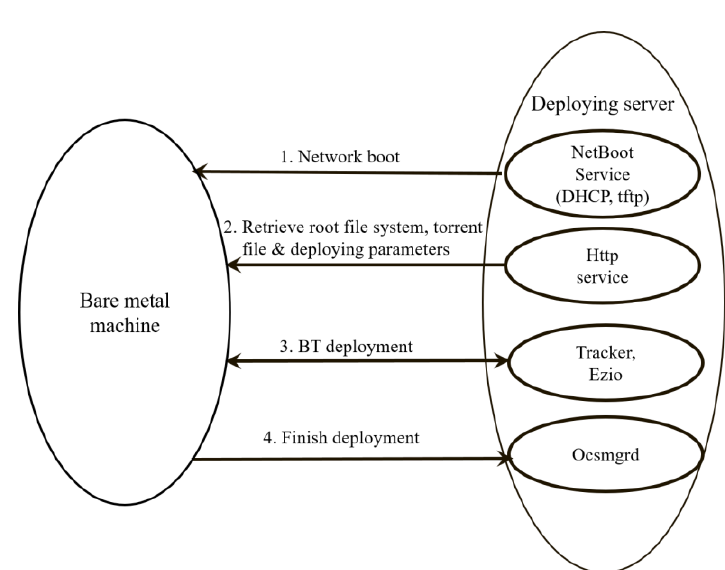
Figure 7. The schematic diagram about a massively deploying image to a bare-metal machine using the BT solution. DHCP: Dynamic Host Configuration Protocol.